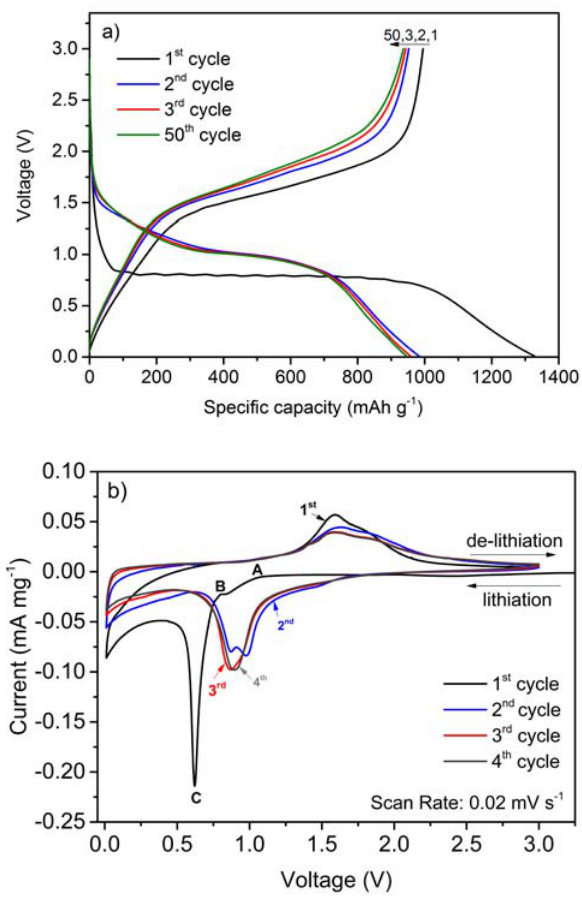
Figure 7. a) Representative voltage vs. specific capacity profiles of the constant current charge/discharge cycling of ZnFe (1 st cycle) and 0.5C (2 nd cycle; 3 rd cycle and 50 th cycle); b) Cyclic voltammetry investigation of the electrode at a scan rate of 0.02 m- V s –1 displaying cycles 1–4. Voltage limits: 0.01 V and 3